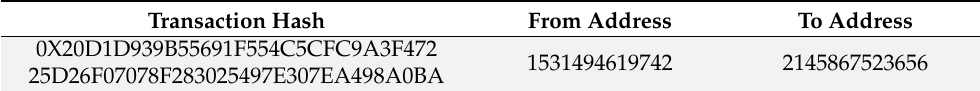
Table 11. Hashing